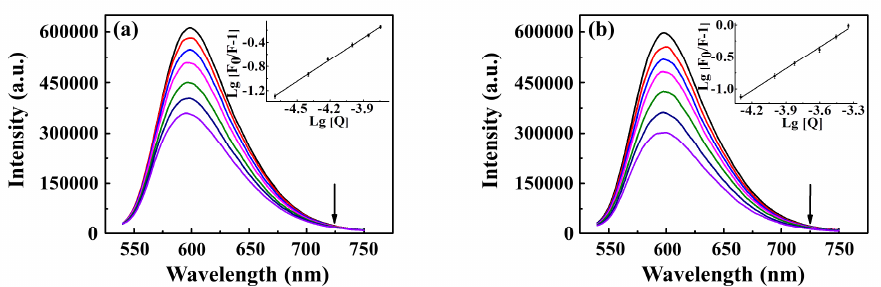
Figure 7. Fluorescence emission spectra of CT-DNA (170 µM) with increasing concentrations of complexes ( a ) Ru-Lbpy 1 and ( b ) Ru-Lbpy 2 . The excitation wavelength is 520 nm, pH 7.4, 298 K. The inset represents Stern-Volmer plot of CT-DNA quenched by complexes, lg [F 0 /F-1] vs. lg [Q].